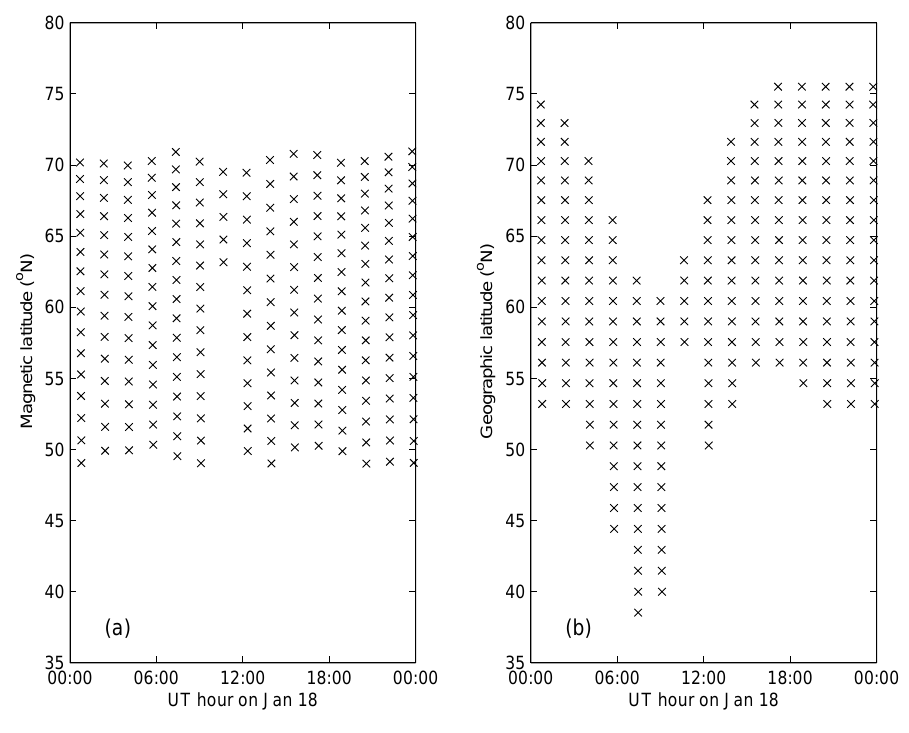
Fig. 2. (a) Locations of MLS/Aura observations at magnetic latitudes between about 50–70 ◦ N on 18 January. (b) The geographic latitudes of the same